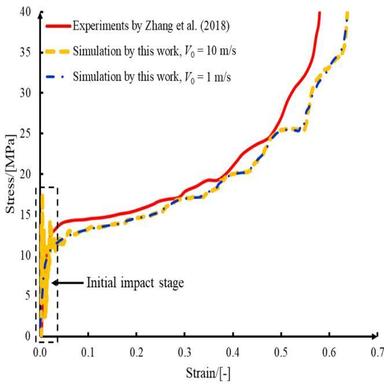
Comparison between stress-strain curves derived from the experiment in) and finite element modelling by this work.